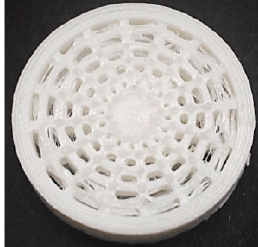
Figure 1. The 3D printer stringing effect appearance of a preliminary sample.